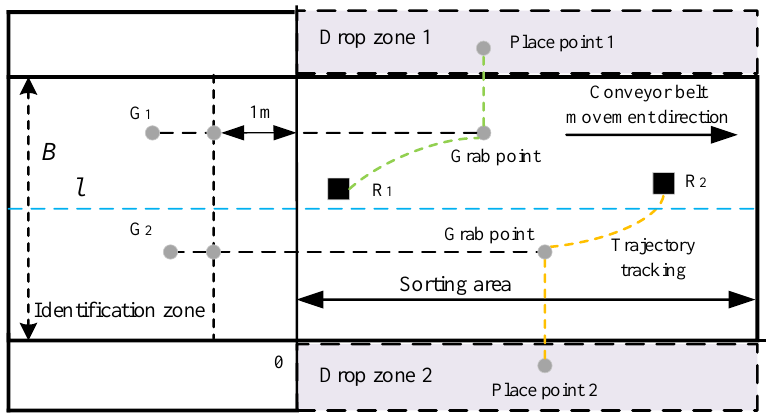
Figure 13. Global dynamic placement point.